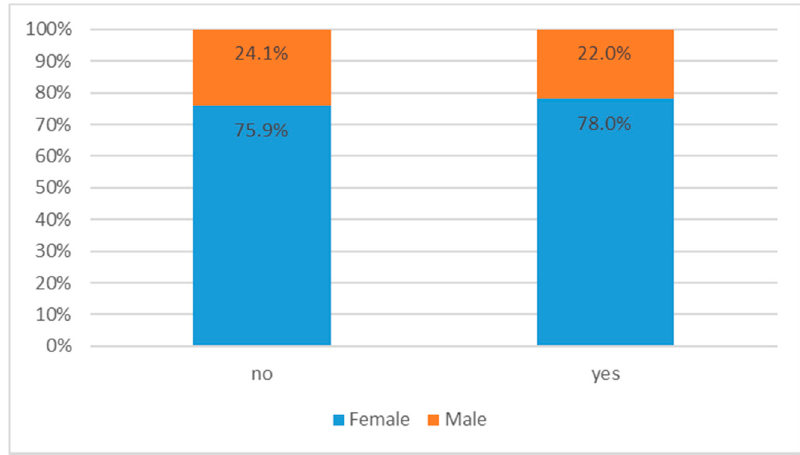
Figure 4. Occurrence of snoring among men and women. P-0.84, Chi^2test.